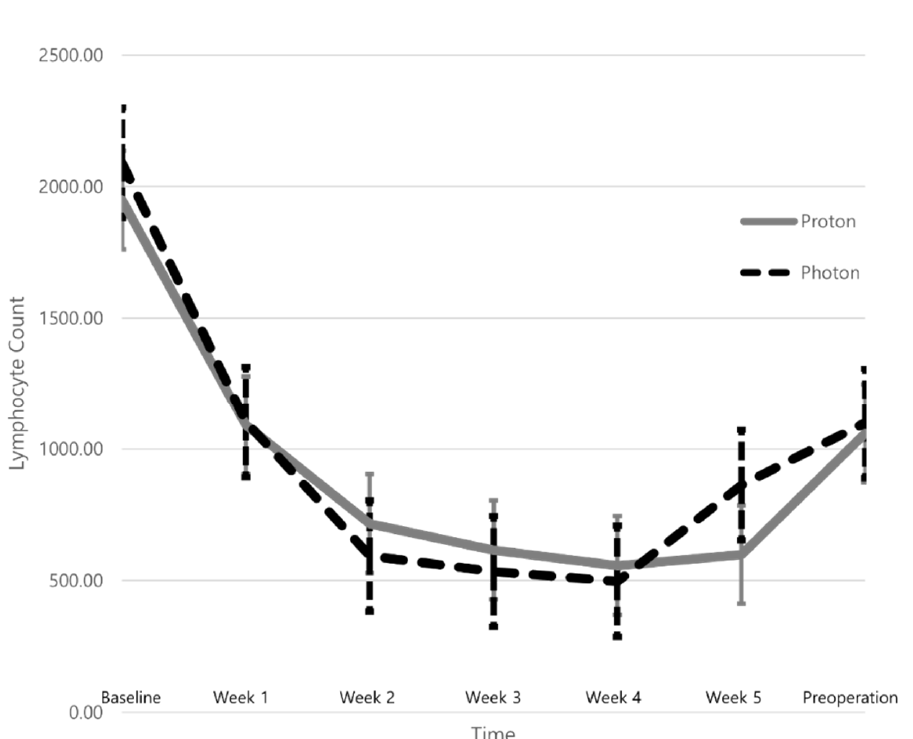
Figure 1. The trend of mean lymphocyte counts of patients with locally advanced esophageal squa- mous cell carcinoma, either Group photon or Group proton , from the baseline through the neoadjuvant chemoradiotherapy, and until before the planned esophagectomy.